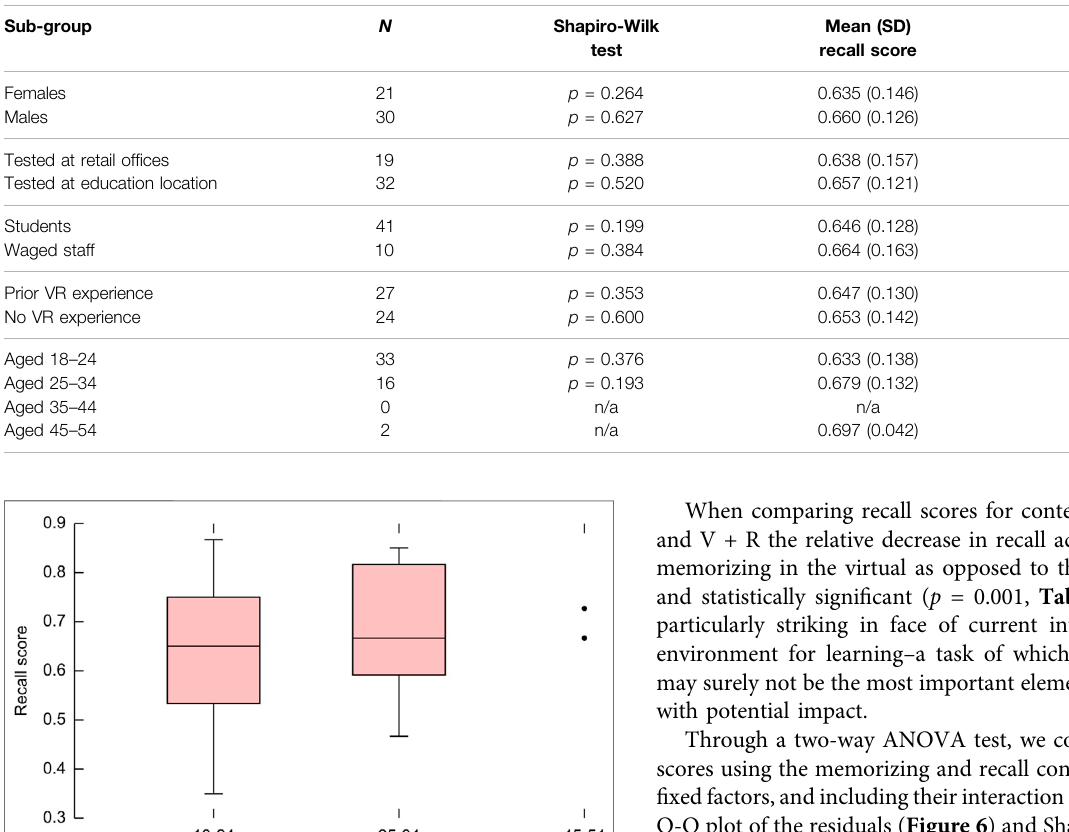
TABLE3| OutcomesoffourindependentsamplesStudent ’ sT-testsandaone-wayANOVAtest( p -valuesandappropriateteststatisticsreported),comparingrecallscores across various demographic sub-samples. Sub-group N Shapiro-Wilk